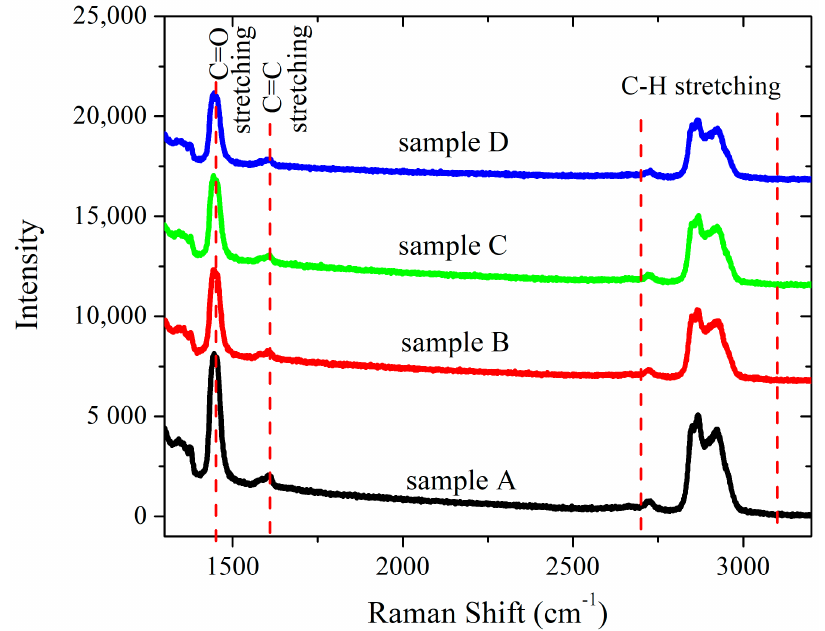
Figure 21. Raman structure of oil samples between 1300 cm − 1 to 3200 cm − 1 Ramanshifts.